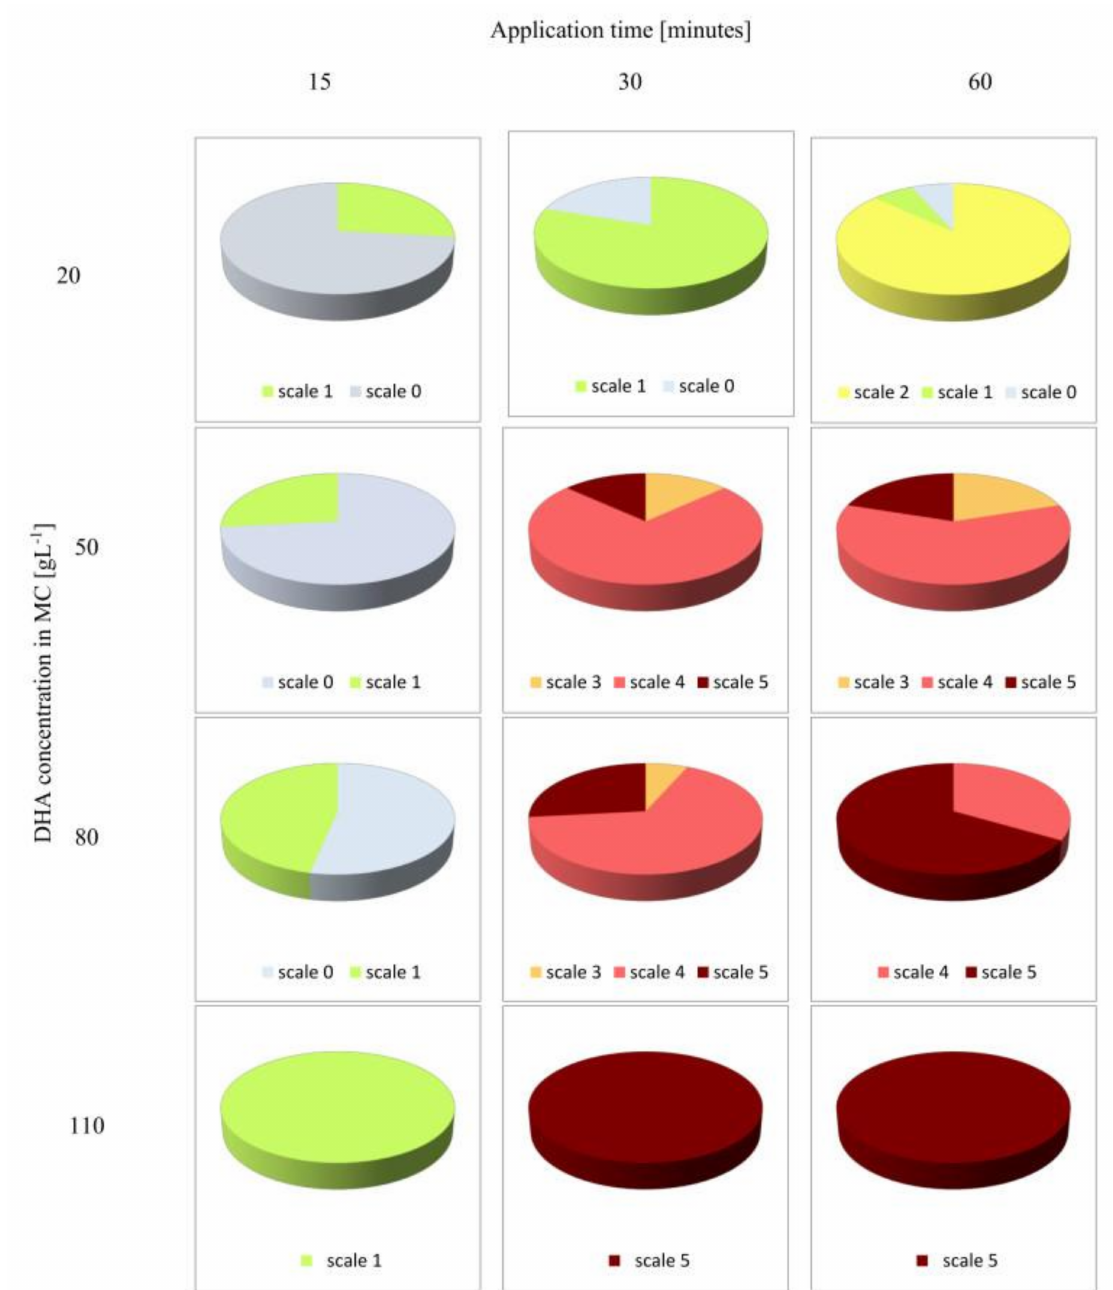
Figure 4. Results of the assessment of skin pigmentation changes conducted by 15 observers. Pigmentation intensity was rated from 0 to 5, where 0 means no color changes, and 5 means the darkest color compared to the control. The shade of brown color was dependent on DHA concentration in the incubation solution, i.e.,